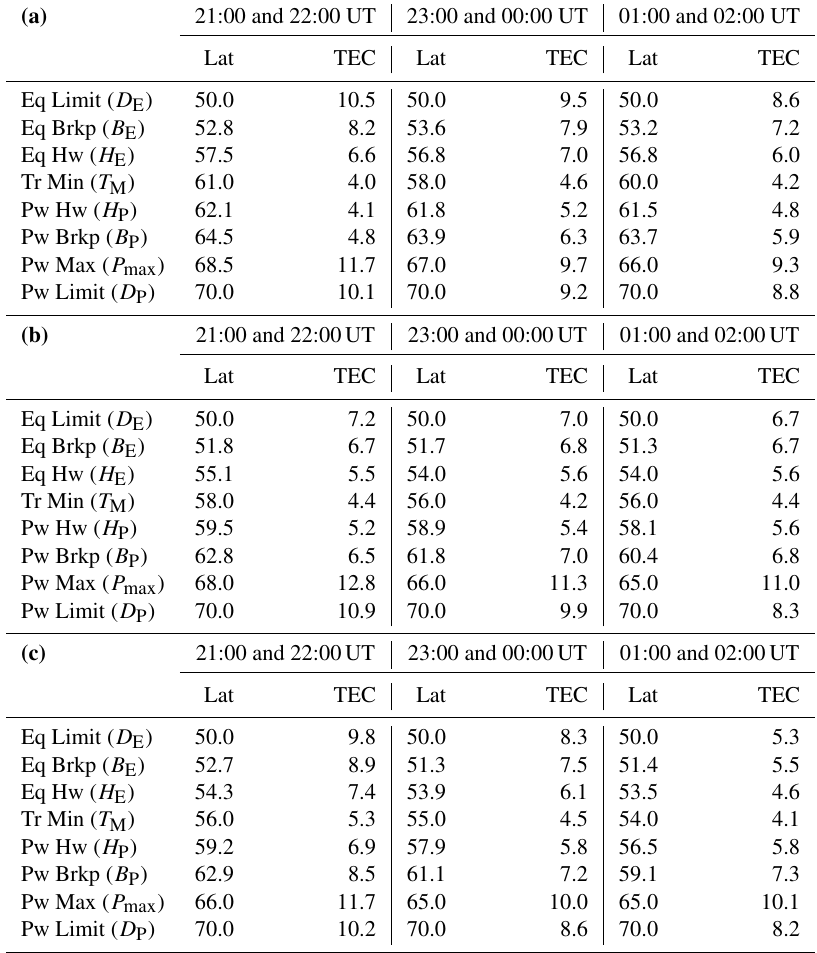
Table 1. (a) Latitude (in degrees north) and VTEC (in TECU) of the set of parameters used to characterize the shape of the trough obtained from the EDAM model for low geomagnetic activity, Kp (0 to 2 + ) . (b) Latitude (in degrees north) and VTEC (in TECU) of the set of parameters used to characterize the shape of the trough obtained from the EDAM model for medium geomagnetic activity, Kp (3 − to 4). (c) Latitude (in degrees north) and VTEC (in TECU) of the set of parameters used to characterize the shape of the trough obtained from the EDAM model for high geomagnetic activity, Kp ( ≥ 4 + )